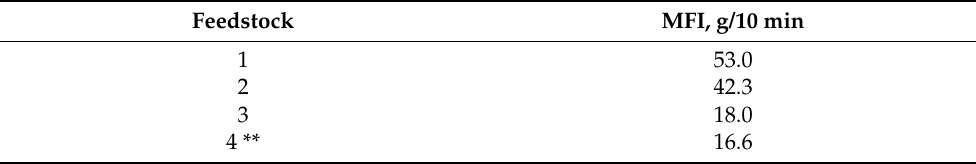
Table 4. Melt Flow Index of feedstocks.